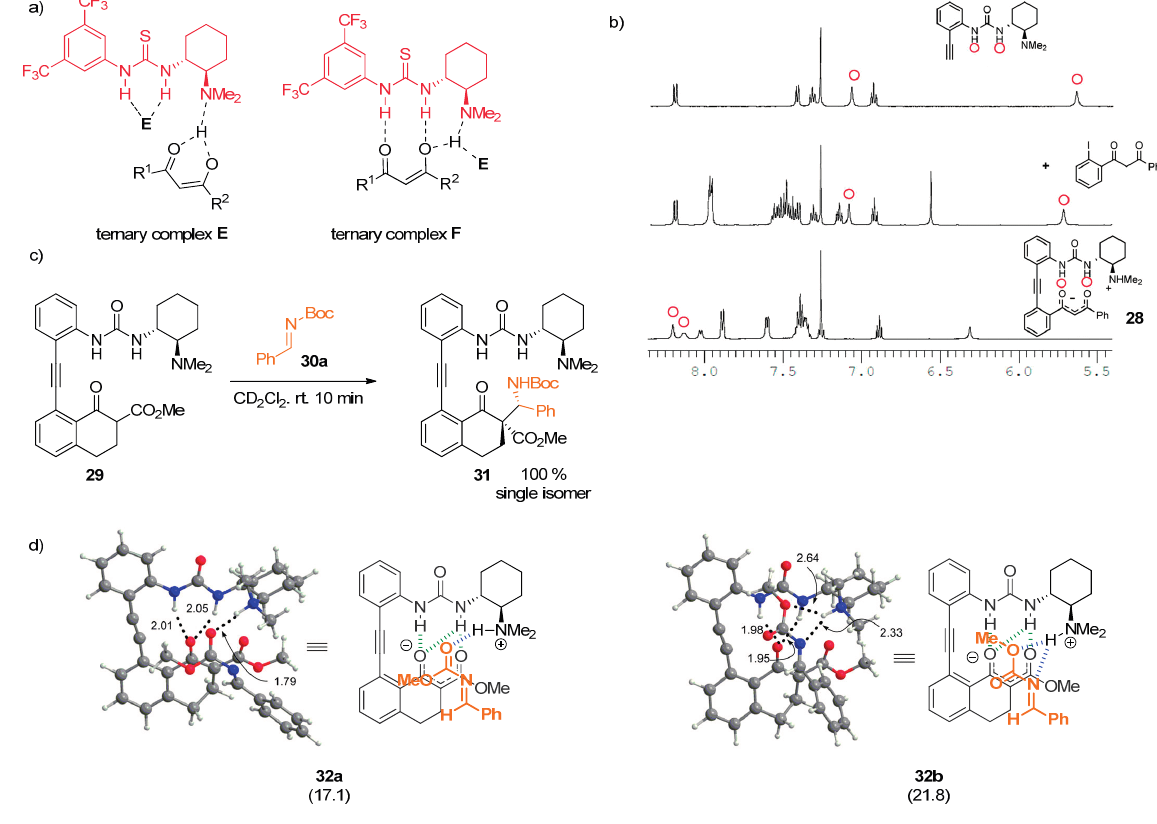
Figure 8. Ternary complexes of thiourea with 1,3-dicarbonyl compound ( a ); 1 H-NMR shifts in 28 ( b ); reaction of 29 with an electrophile ( c ); two proposed channels of imine coordination ( d ). Adapted with permission from Ref. [19]. Copyright (2014) American Chemical